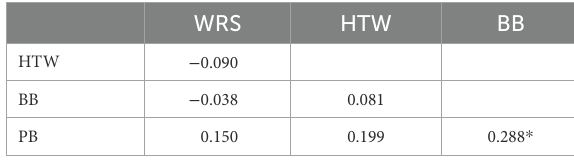
TABLE 7 Results from Spearman’s Rho bivariate correlation analysis for motor competence ( N =